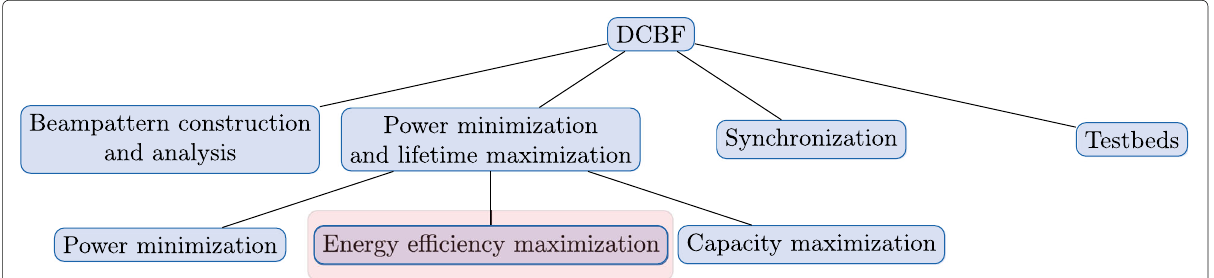
Fig. 1 Research trends. Research directions in DCBF in wireless